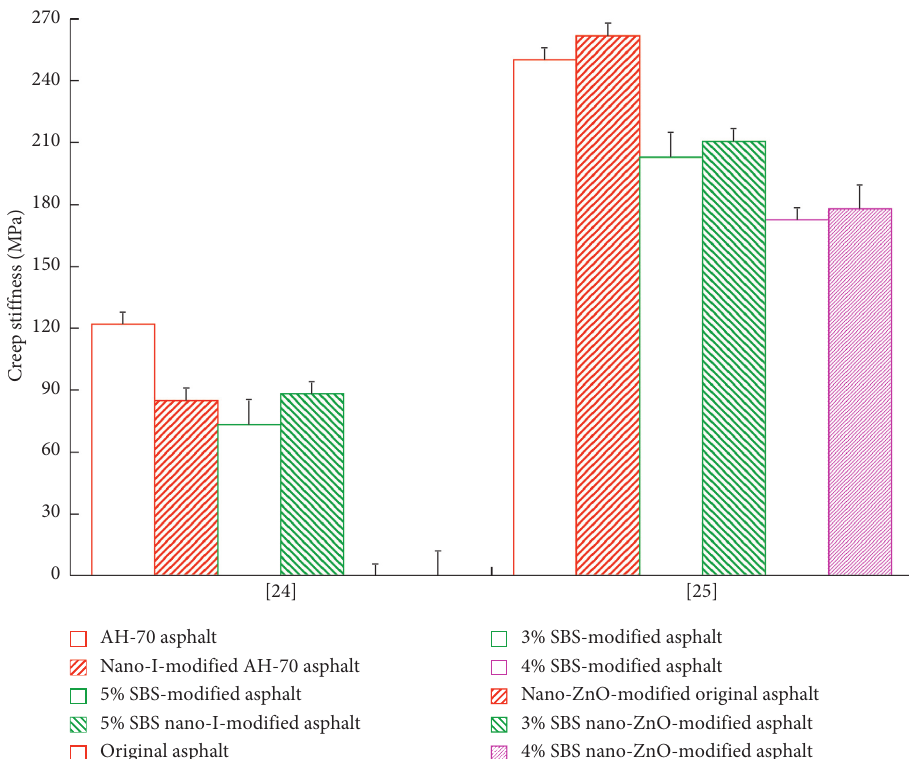
Figure 4: Creep stiffness of different asphalt at − 12 °